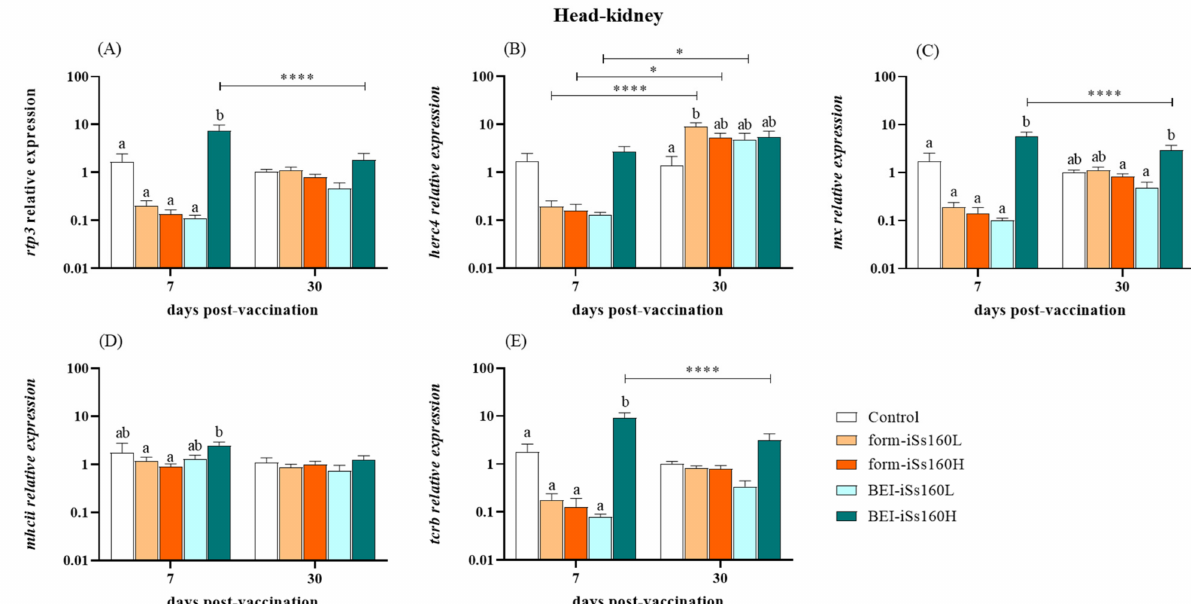
Figure 2. Vaccination produces the increment of immune response at transcriptional level in head-kidney. Expression of immune-related genes ( A ) rtp3 , ( B ) herc4 , ( C ) mx , ( D ) mhcii and ( E ) tcrb in the head-kidney of Senegalese sole specimens 7-, 15- and 3-days after intraperitoneal vaccination with low and high dosages (10 5 and 10 7 TCID 50 /mL, iSs160L and iSs160H, respectively) of BEI-iSs160 vaccine (inactivated with BEI) and form-iSs160 (formalin inactivated) or PBS (Control). Data represent the mean ± standard error of the mean (SEM; n = 6 fish/group and time). Lower letters denote statistical differences between groups at a same time-point ( p < 0.05), whilst asterisks indicate those between time-points in the same group (* p < 0.05; **** p < 0.0001).